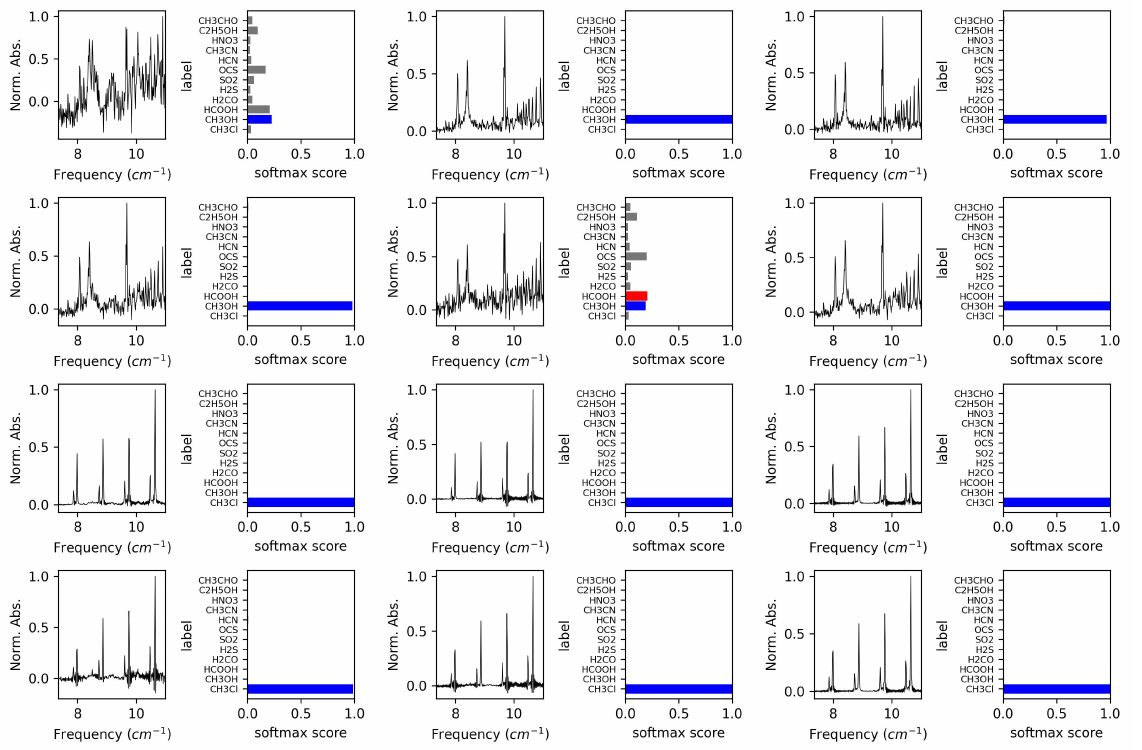
Figure 13. VOC-Net classification of experimental spectra (13–24). The corresponding softmax scores for each classification are given with each